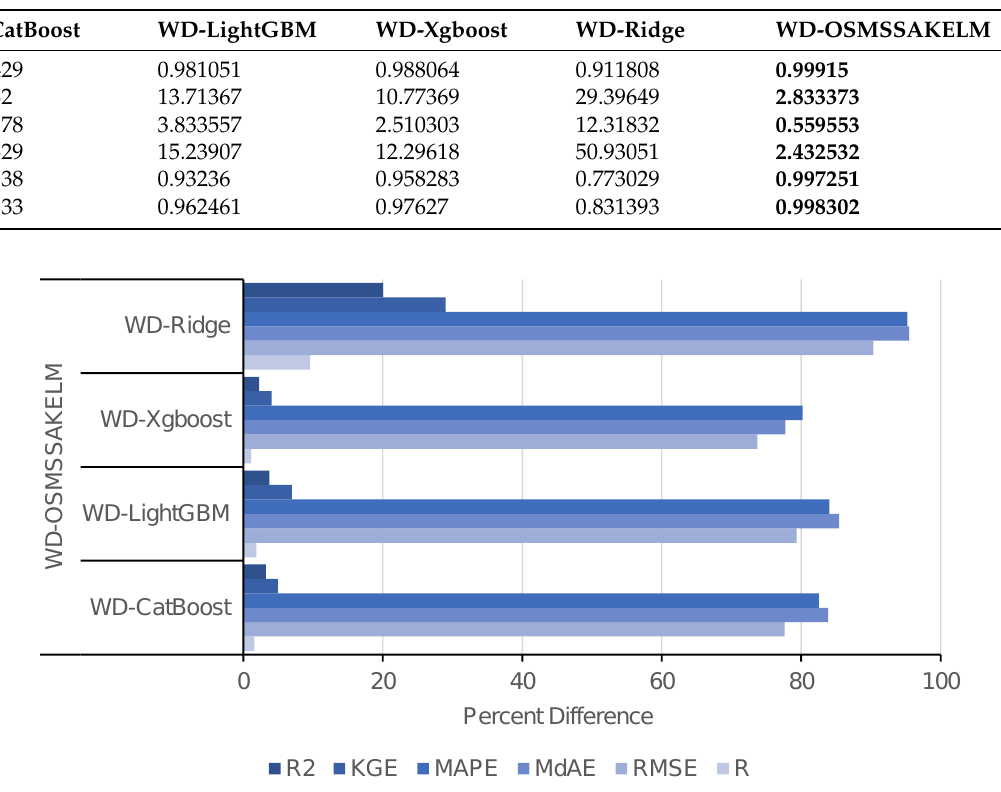
Figure 17. Percent (%) of improvement of the WD-OSMSSAKELM versus the values of other methods for the metrics during the training